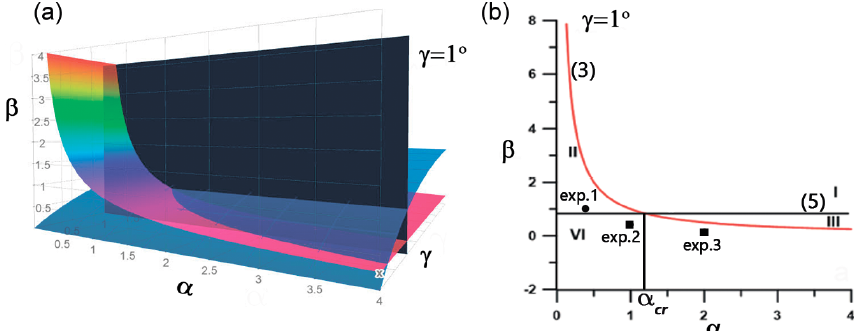
Figure 5. (a) A three-dimensional diagram of regimes with the cross section αβ for γ = 1 ◦ . In panel (b) , the red line corresponds to the polarity change criterion (3), and the black line corresponds to the breaking criterion (5); the circles represent cases of changing polarity but without wave breaking, and squares represent cases of changing polarity with wave